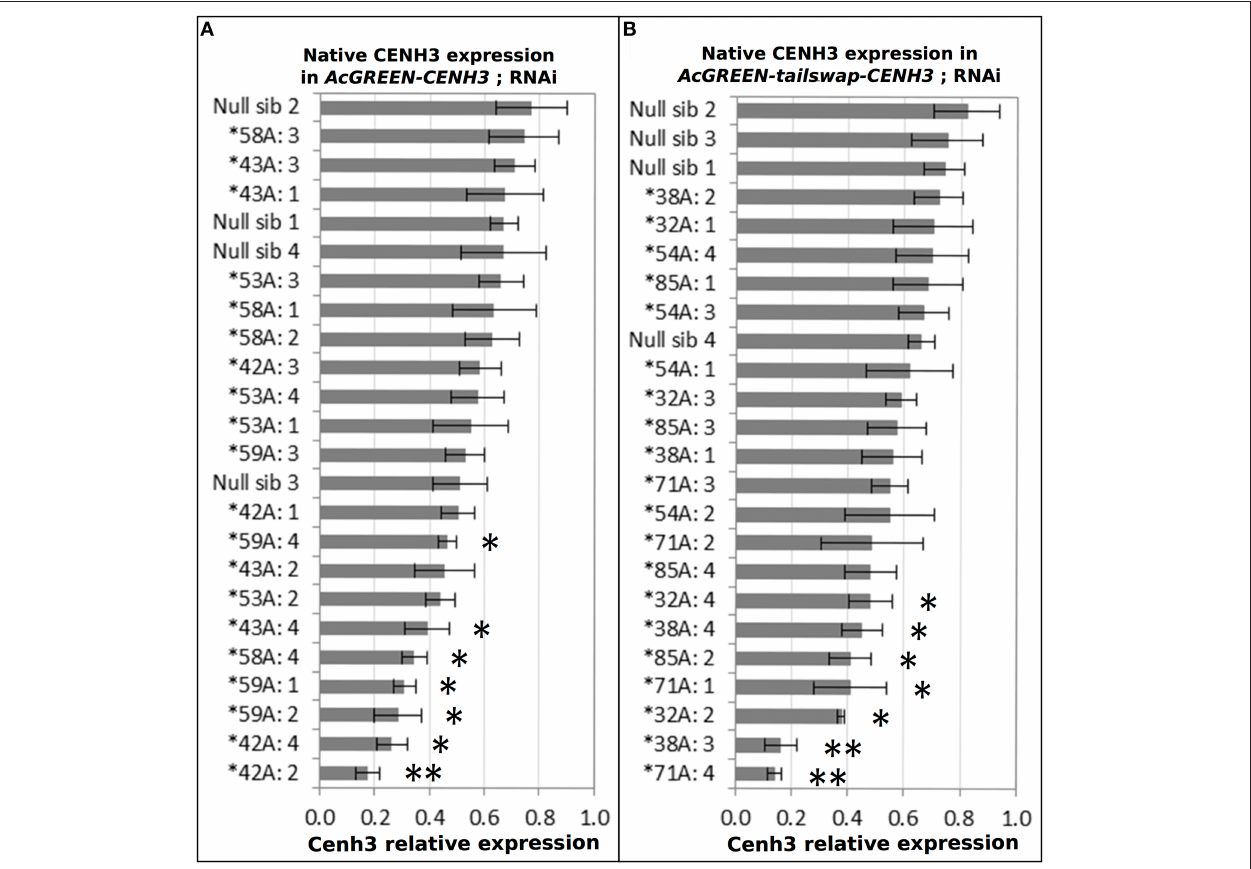
FIGURE 3 | Cenh3 knockdown by RNAi. Five events from each RNAi construct were grown and four transgene-homozygous individuals from each were sampled to measure the extent of Cenh3 knockdown. Four transgene-negative siblings from each construct were sampled and tested for comparison (Null sib 1-4). Samples were analyzed by qRT-PCR using a primer pair specific to the CENH3 tail. The X-axis is a ratio of Cenh3 expression to the endogenous control. Individuals were tested in triplicate and error bars indicate the standard deviation in the replicates. Results are displayed in rank order with the highest relative expression at the top of each chart. (A) Native CENH3 expression levels in individuals from AcGREEN-CENH3 + CENH3:RNAi events. (B) Native Cenh3 expression levels in individuals from AcGREEN-tailswap-CENH3 + CENH3:RNAi events. In total, fourteen individuals had significant Cenh3 knockdown ( * p < 0.01 ; ** p < 0.001 ) and these, along with a few selected others, were forwarded to reproductive evaluations and haploid induction